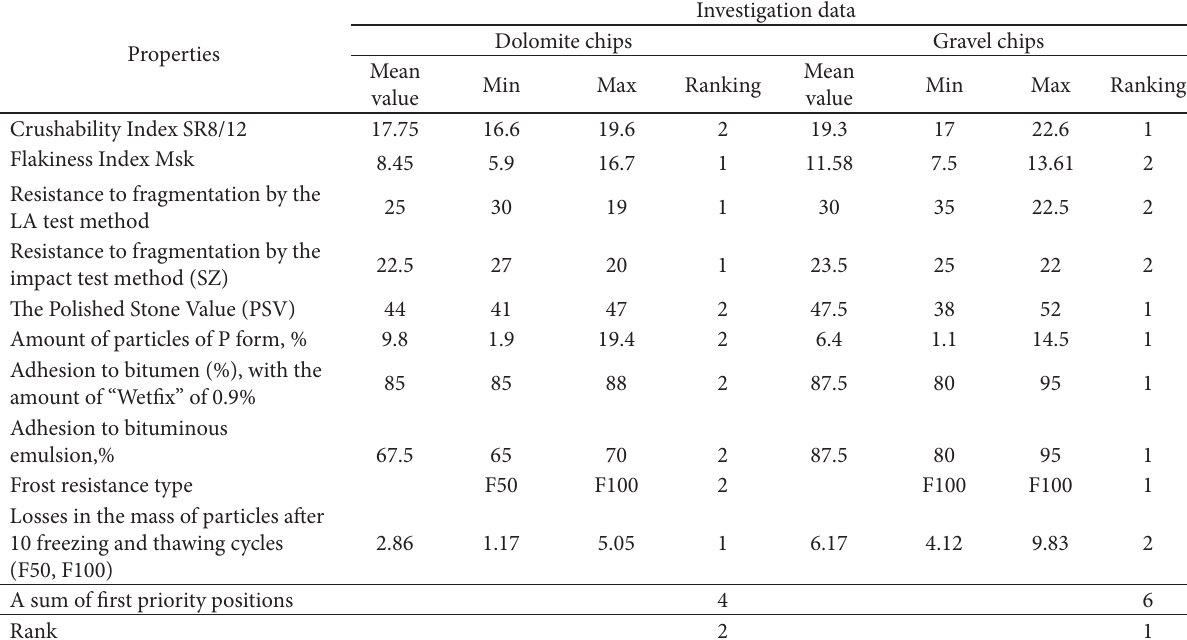
Table 2. Comparison of the properties of crushed gravel and crushed dolomite